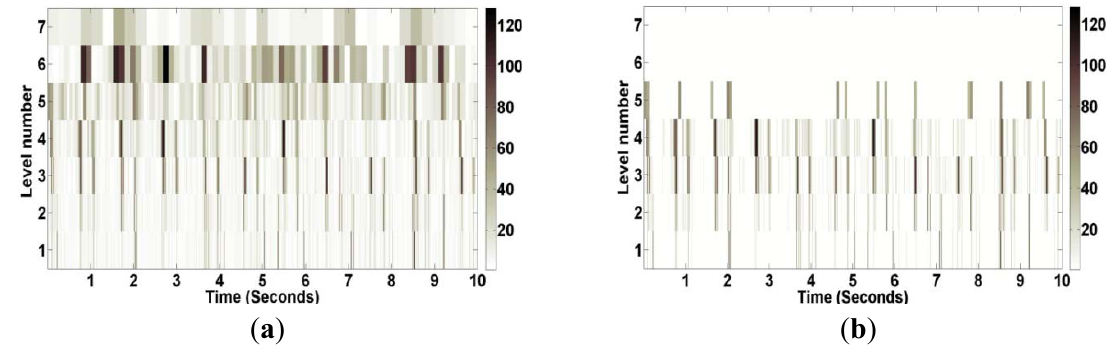
Figure 11. ( a ) Original and ( b ) Thresholded Coefficients of Heart Sounds using Daubechies Wavelet.